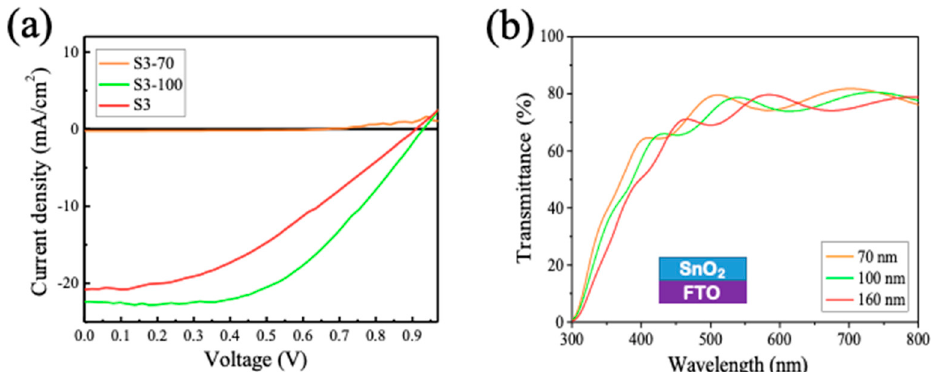
Figure 6. ( a ) J-V characteristics of PSC incorporating SnO 2 thin films with different thicknesses ( b ) the transmittance spectra of the SnO 2 thin films with varied thicknesses. The SnO 2 was annealed at 300 °C and, for the transmittance measurement, SnO 2 /FTO samples were used. Table 2. The performance of PSCs with 300 °C annealed SnO 2 with varied thickness.